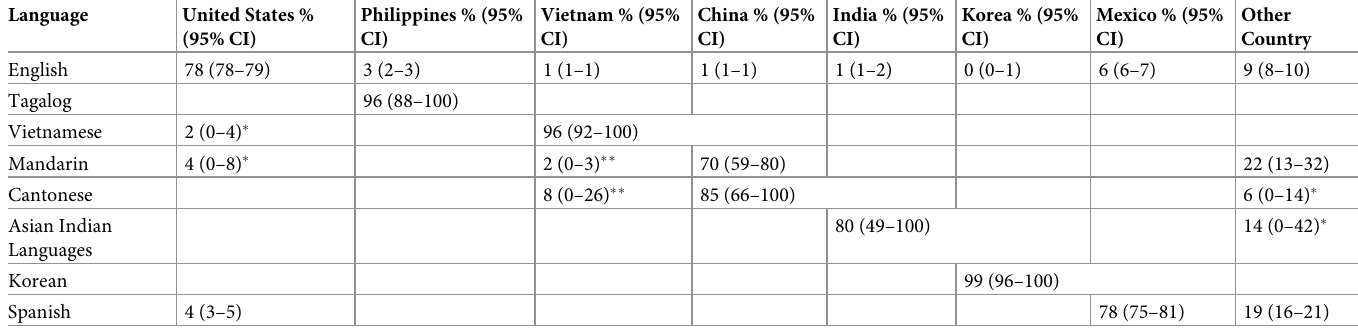
Table 4. Proportion country of birth by language spoken in medical visit, California